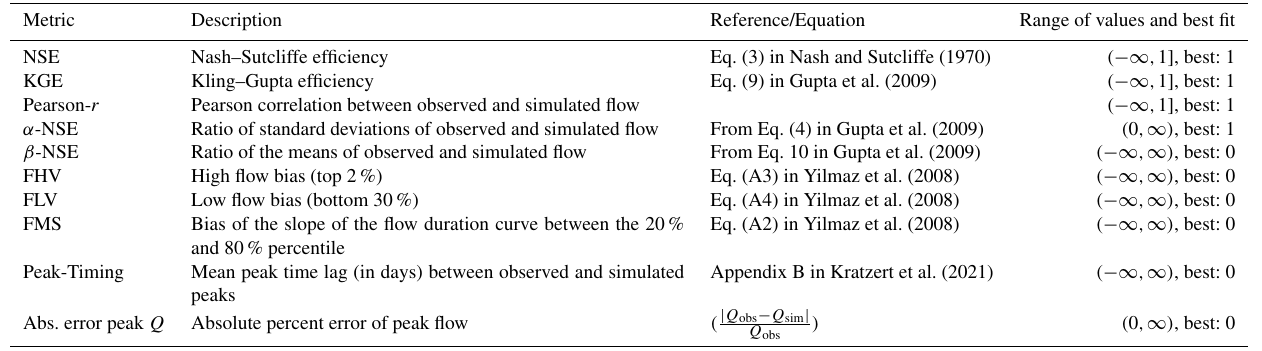
Peak-Timing Mean peak time lag (in days) between observed and simulated